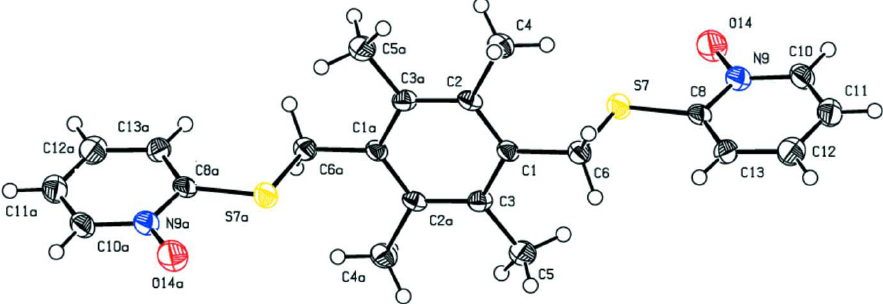
The molecular structure of the title compound, showing 50% probability displacement ellipsoids. Atoms labelled with the suffix a are generated by the symmetry operations (1 - x , 1 - y , 1 - z